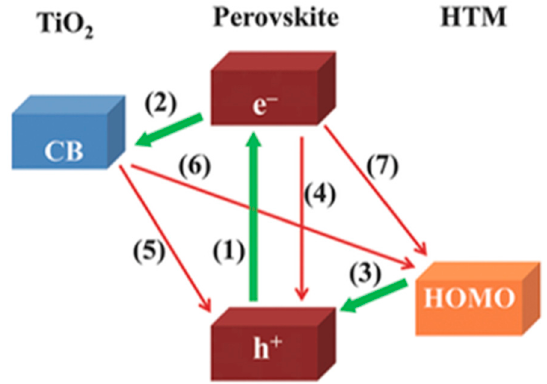
Figure 3. Charge-transfer processes in perovskite solar cells. The valence band energy and the conduction band (CB) of methyl ammonium lead iodide (MAPbI 3 ) perovskite are at − 5.43 eV and − 3.7 eV, respectively. The CB of TiO 2 lies at − 4.2 eV, and the HOMO energy level of the widely-used HTM spiro-OMeTAD is at − 5.22 eV [5] (reproduced with permission from [5], published by John Wiley & Sons, Inc.).